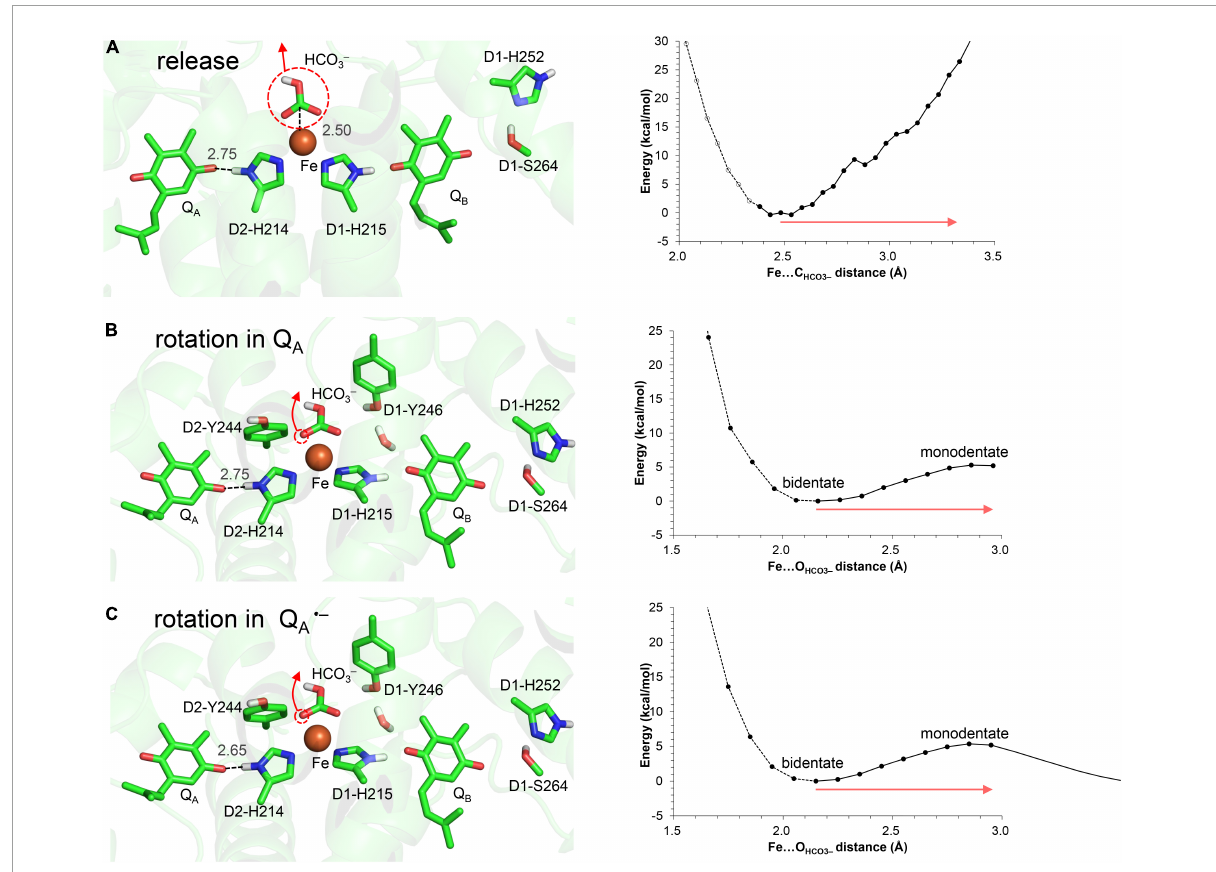
FIGURE3 Energy profile for the bicarbonate displacement. (A) Release of the bicarbonate ligand from the Fe 2 + site. (B) Bidentate-to-monodentate reorientation of the bicarbonate ligand in neutral Q A . (C) Bidentate-to-monodentate reorientation of the bicarbonate ligand in Q A ·− . Red arrows indicate the orientations of the bicarbonate displacement. Note that the geometry of each intermediate conformation is fully QM/MM